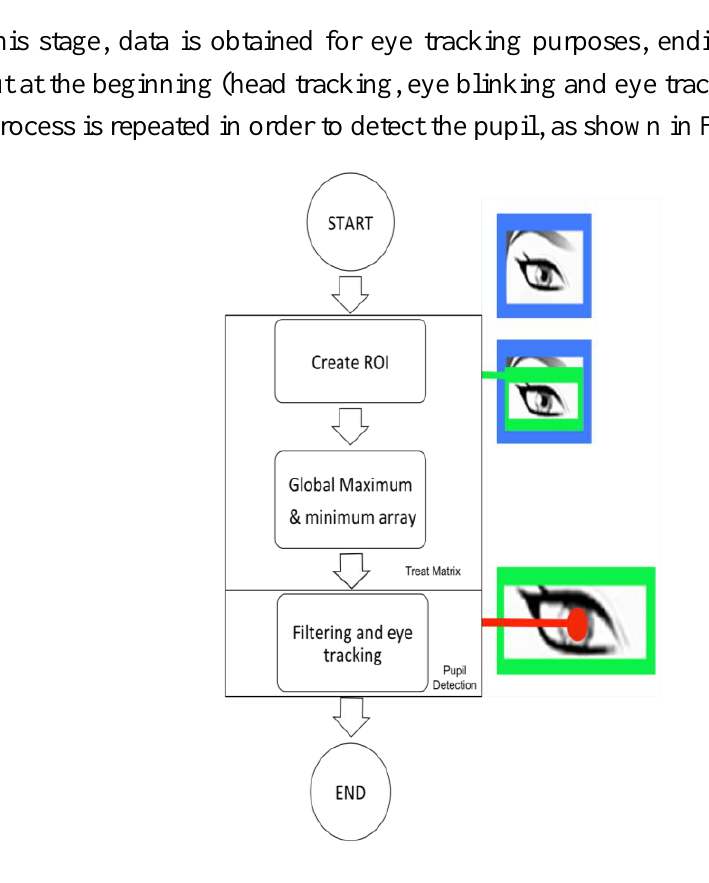
Figure 11. Low-level diagram of fourth stage.